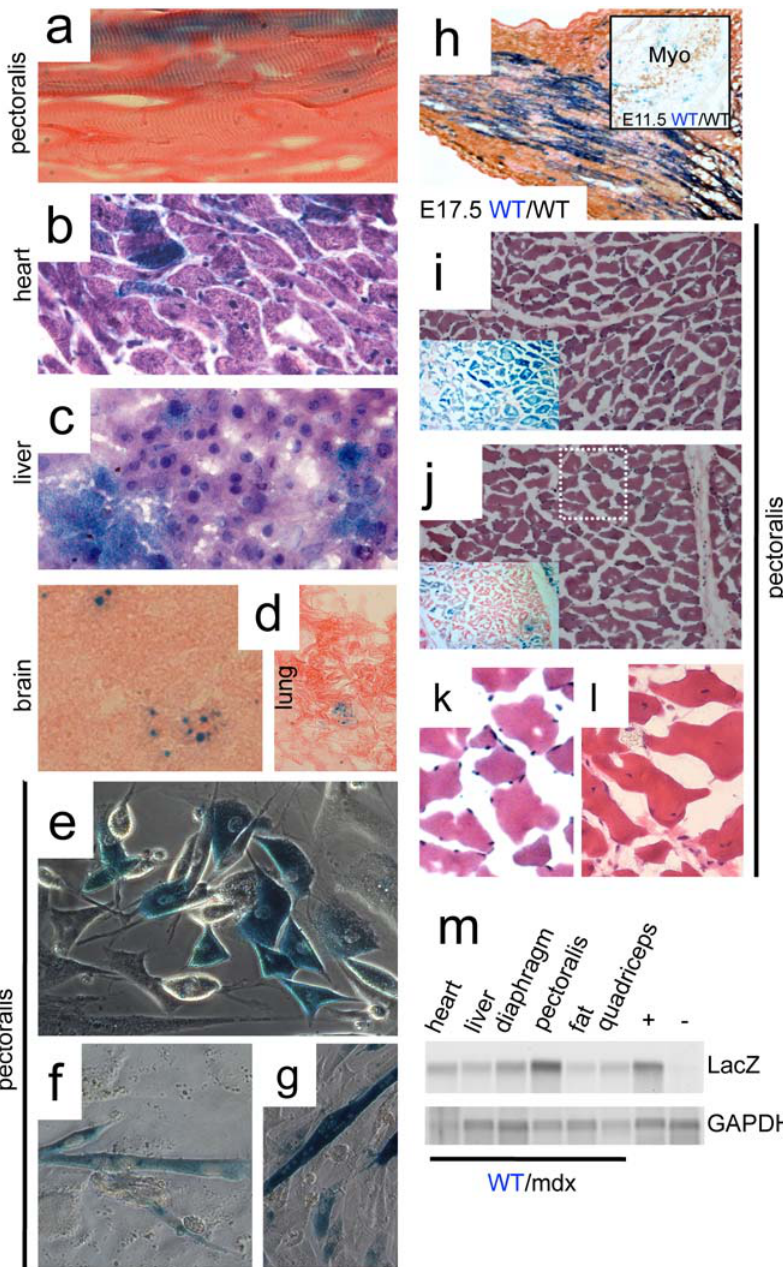
Figure 3. b -galactosidase activity is detected in chimeric tissues. a–d, Xgal (blue) staining of sections of pectoralis muscle (a, longitudinal), heart (b), liver (c), brain (d, left) and lung (d, right) from 10–30% R26 WT/mdx chimeric mice (400 6 for a–c and 200 6 for d). a and d: eosin counterstained; b and c: H&E counterstained. Xgal staining in (d) (brain and lung) was weak and punctuated. e–g, myogenic cells (e) were isolated from pectoralis muscle of 10–30% R26 WT/mdx chimeric mice, and subjected to differentiation into multinucleated, contracting myotubes (f, g)(400 6 ). h, E17.5 R26 WT/WT embryos were collected, cryosectioned at the hindlimb level and Xgal/eosin stained (200 6 ). Adjacent sections were MHC (MF20) immunostained to visualize the developing muscle (not shown). h inset, E11.5 R26 WT/WT embryos were collected, whole mount